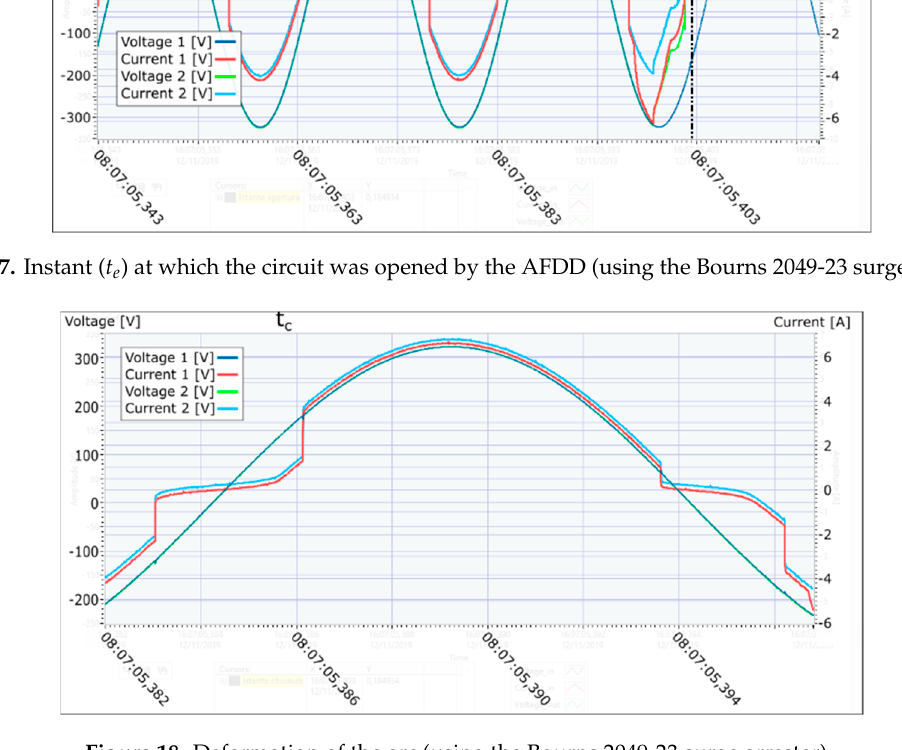
Figure 18. Deformation of the arc (using the Bourns 2049-23 surge arrester).